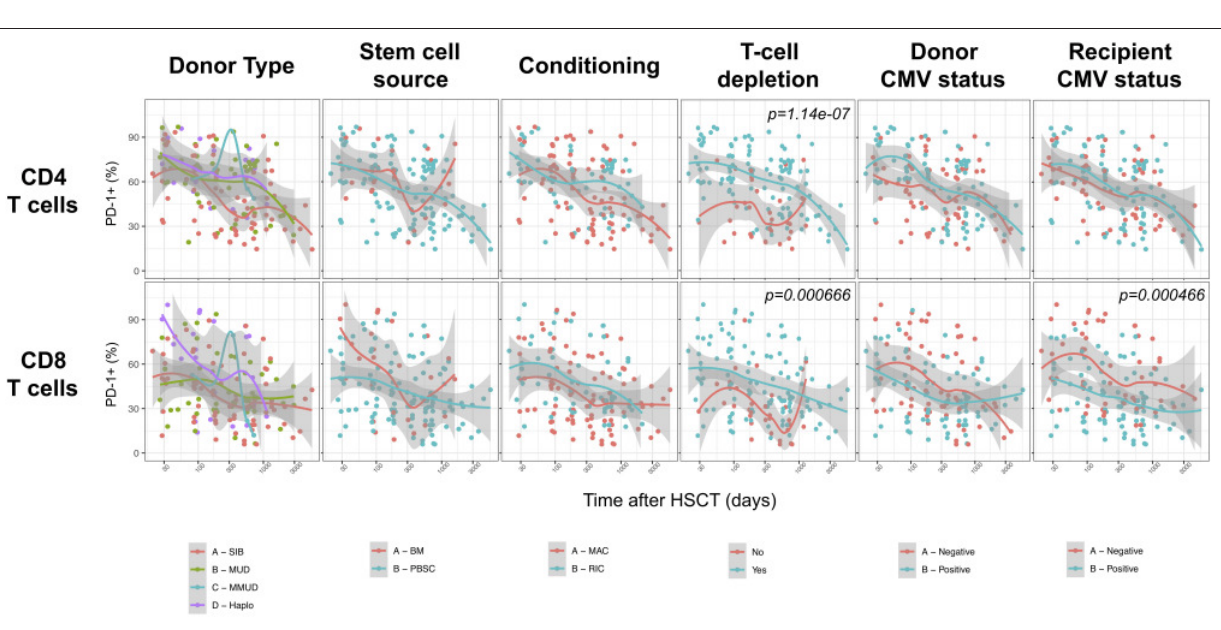
FIGURE 4 | Impact of clinical factors on PD-1 expression at CD4 and CD8T cells surface after allogeneic HSCT. Comparison of PD-1 expression on CD4 and CD8 T cells from HSCT recipients depending on donor type, stem cell source, conditioning, T-cell depletion and donor/recipient CMV status. The p -values resulting from the multivariable linear regression analysis are indicated when